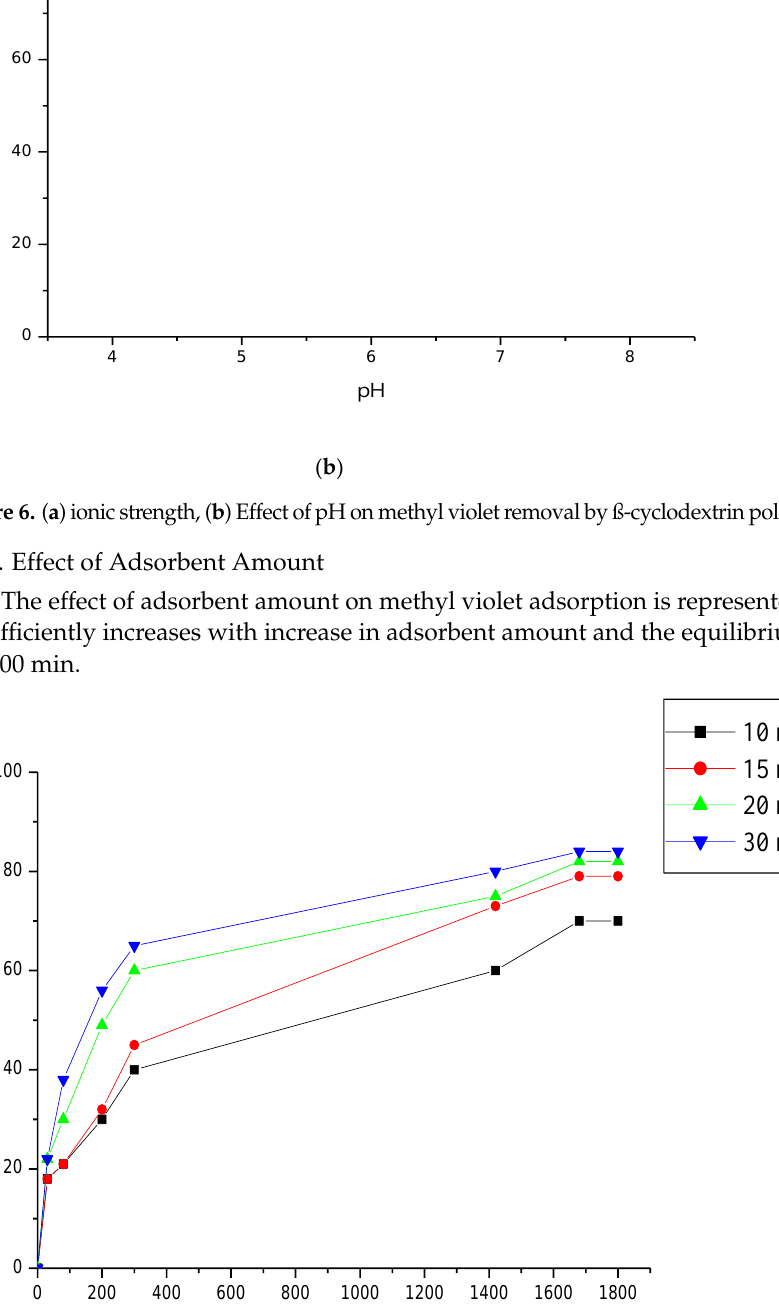
Figure 7. Effect of ß-cyclodextrin polymer amount on methyl violet removal, pH = 4, T = 30 °C.